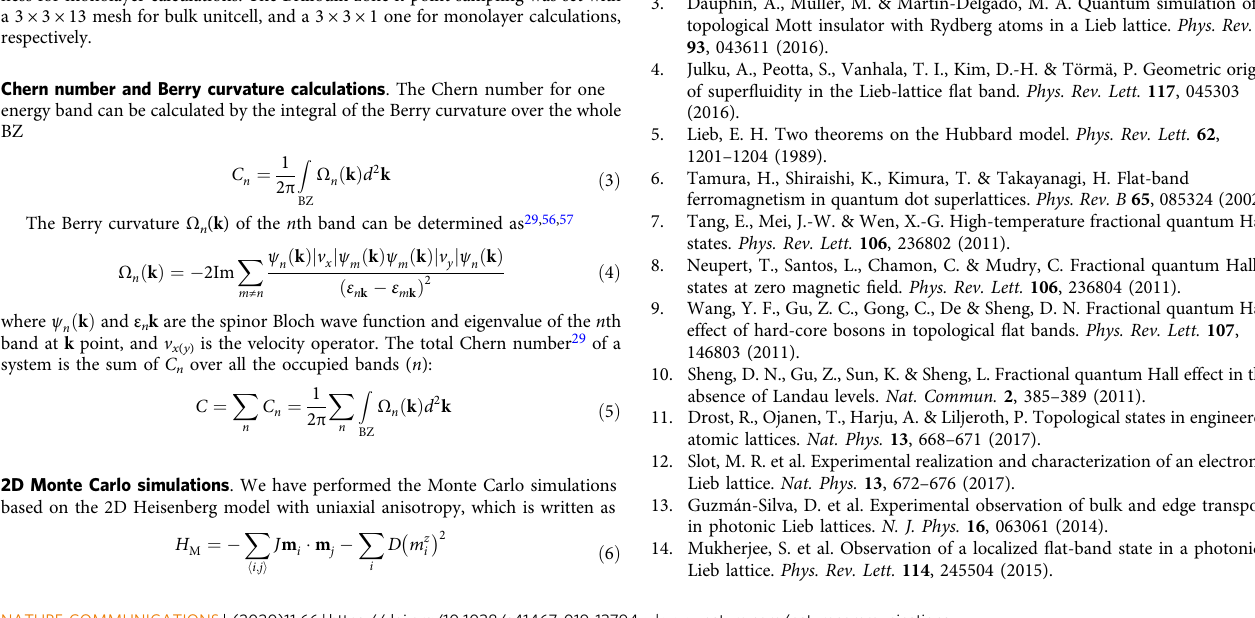
sp 2 C-COF, calculated by the MC simulations with 2D Heisenberg models with the